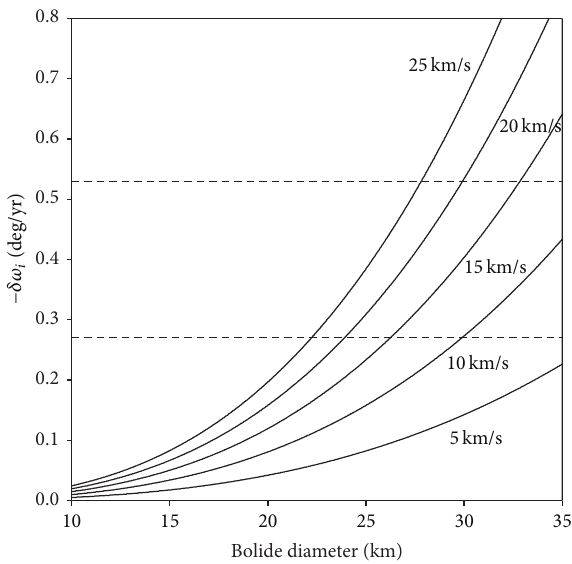
Figure 2: Magnitude of the impact-induced superrotation of the Earth’s inner core ( −𝛿𝜔 𝑖 ) as a function of bolide diameter and speed. The horizontal dashed lines indicate the range of superrotation reported by Zhang et al.